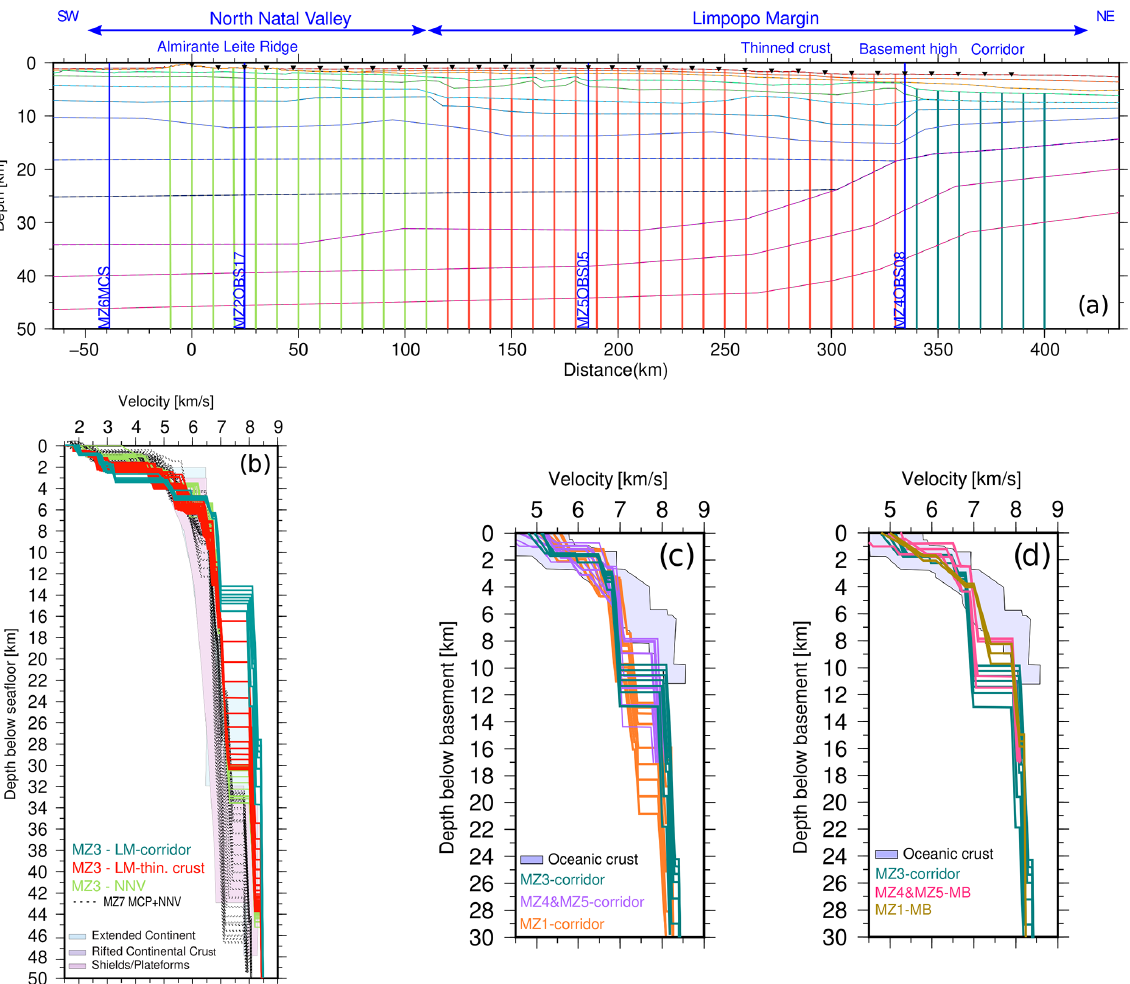
Figure 16. (a) The 1D velocity–depth (vz) profiles extracted along MZ3 final velocity model and color coded according to main domains and segments. (b) MZ3 vz profiles below the seafloor compared to MZ7 vz profiles of the MCP and NNV, and compiled vz profiles of continental crust for different settings (Christensen and Mooney, 1995). (c) Comparison of vz profiles below the acoustic basement of the corridor of anomalous crust extracted from MZ1 (Moulin et al., 2020; Schnürle et al., 2018), MZ3 (this study), MZ4 and MZ5 (Watremez et al., 2021) models with a compilation of vz from “normal” Atlantic oceanic crust (White et al., 1992). (d) Comparison of MZ3 vz profiles below the acoustic basement of the corridor of anomalous crust with vz for the oceanic crust of the MB extracted from MZ1 (Moulin et al., 2020; Schnürle et al., 2018), MZ4 and MZ5 (Watremez et al., 2021) and compared to the compilation of White et al.